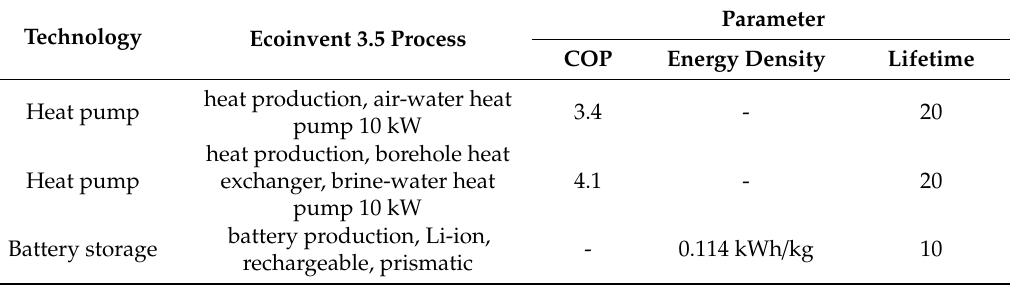
Table 3. Parameterized